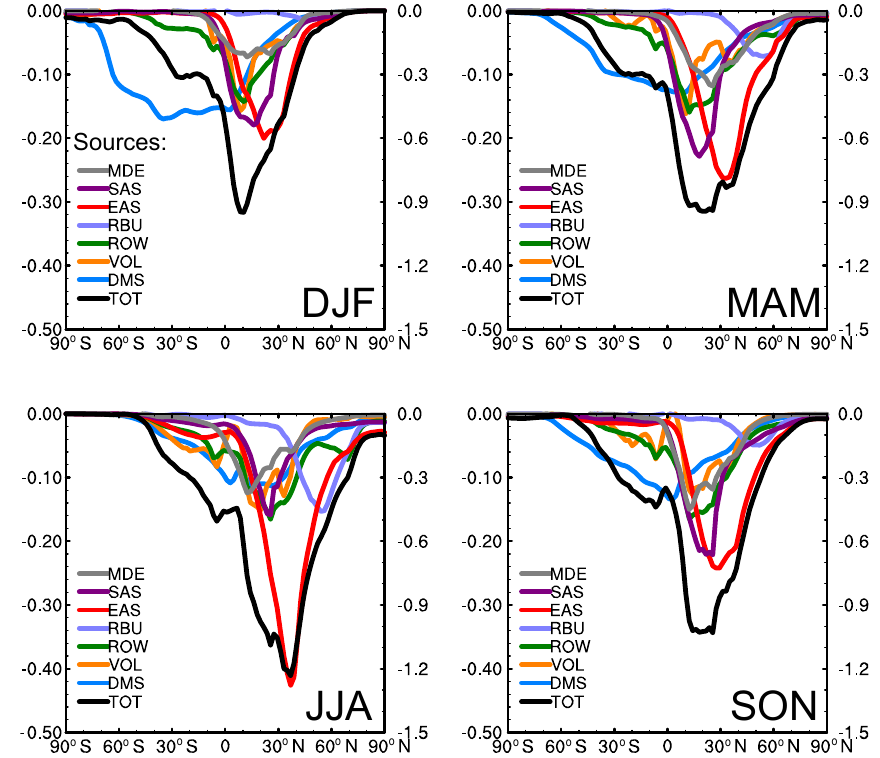
Figure 8. Contributions to zonal mean sulfate direct radiative forcing (Wm − 2 ) from emissions of the tagged regions/sectors shown in colors (left y axis) and from global total emissions shown in black (right y axis). Only regions with maximum of zonal mean sulfate direct radiative forcing stronger than − 0.1Wm − 2 are shown